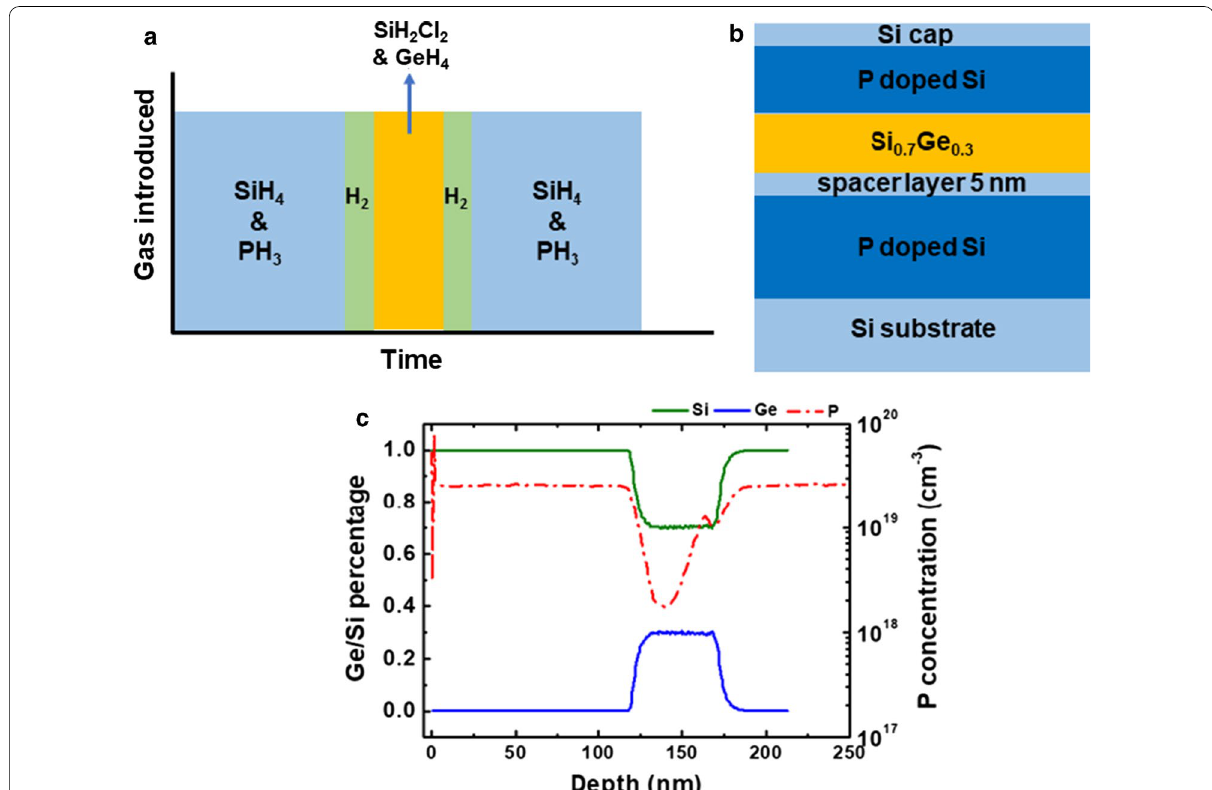
Fig. 4 Schematic diagrams of a doping strategy of changing growth chemistry, b experimental structure of Si/SiGe/Si MLs. The SiGe layer was grown with DCS. The purge time was 5 min with flow of 60 sccm after doped Si. The undoped Si spacer layer was 5 nm between bottom-doped Si and undoped SiGe. c Ge/Si profile and P concentration of P-doped Si/Si 0.7 Ge 0.3 /P-doped Si